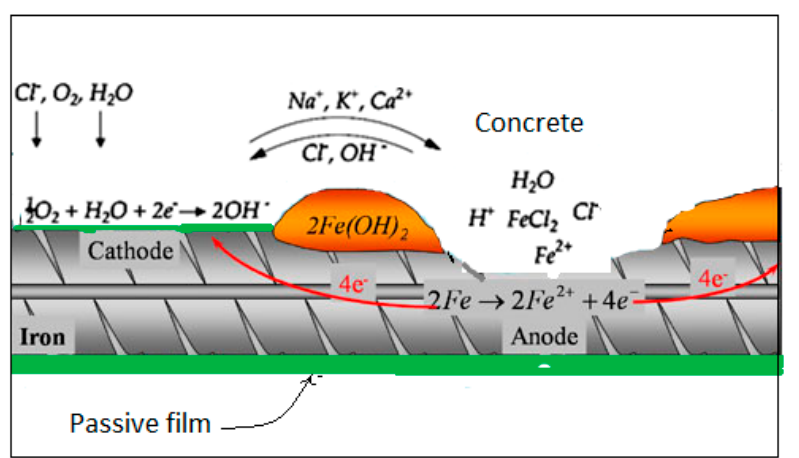
Figure 7. Corrosion of steel bar in concrete [88–90].